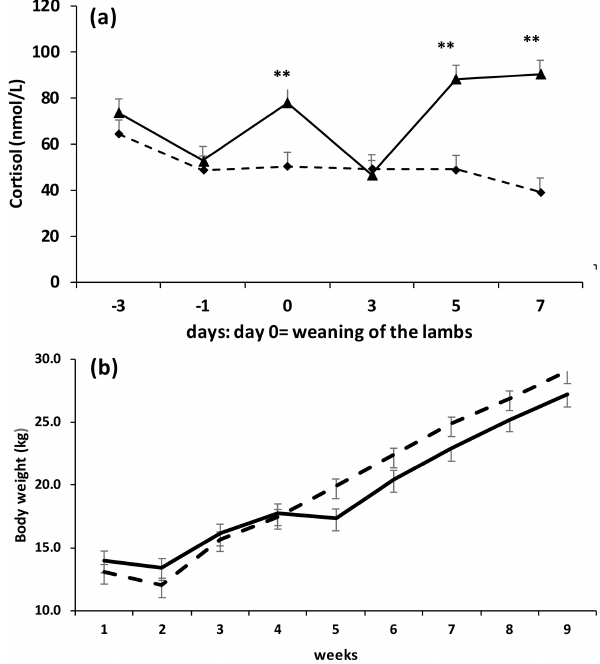
Figure 2. Cortisol levels (a) and body weight (b) in Saint Croix lambs after weaning on average at 60d of age following two meth- ods: complete separation (dotted line) where the lambs were placed in a pen located 500m of distance from the dams and separation with contact from the dams (black line) where the lambs were placed in a pen separated with a steel mesh from the pen of dams ( P< 0 .